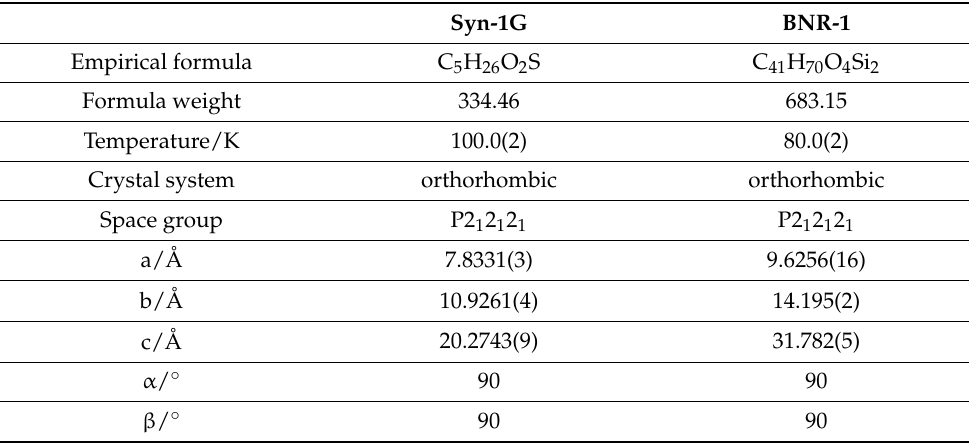
Table 5. Experimental details for Syn-1G and